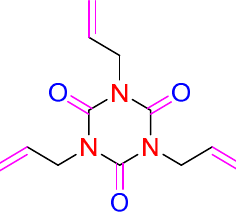
Figure 1. The chemical structure of TAIC.